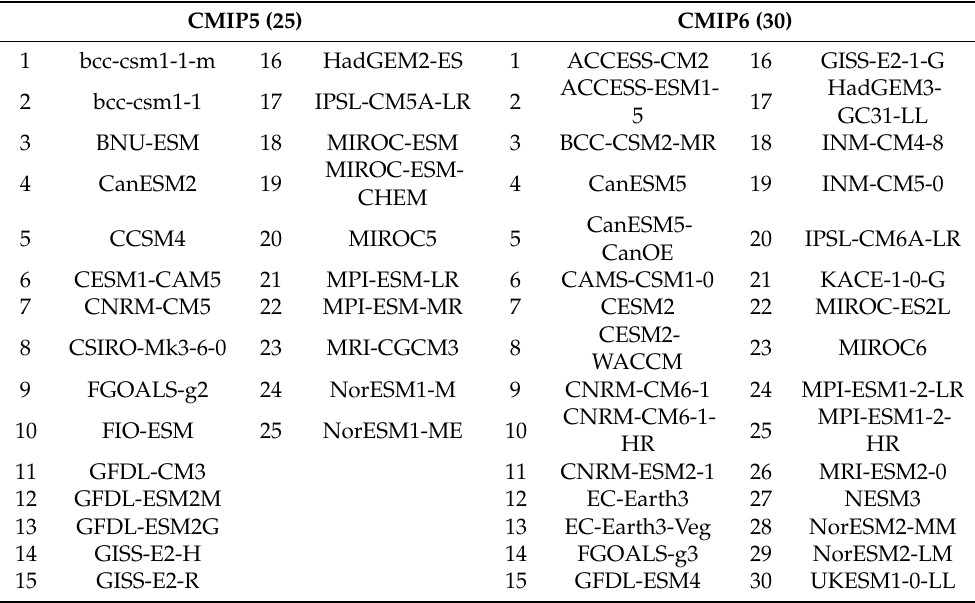
Table 1. A list of the models used in the present